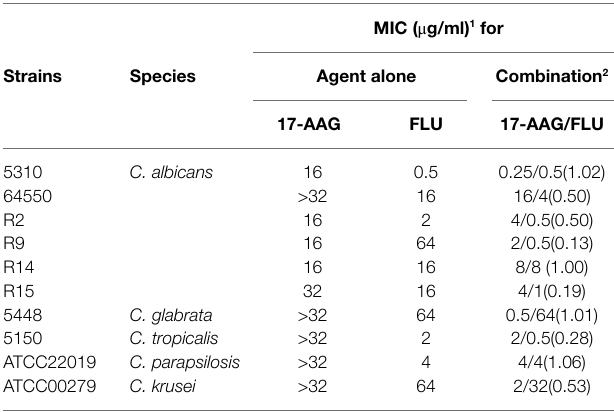
TABLE 2 | MICs and FICIs results with the combinations of 17-AAG and FLU against azole-resistant Candida. Strains Species